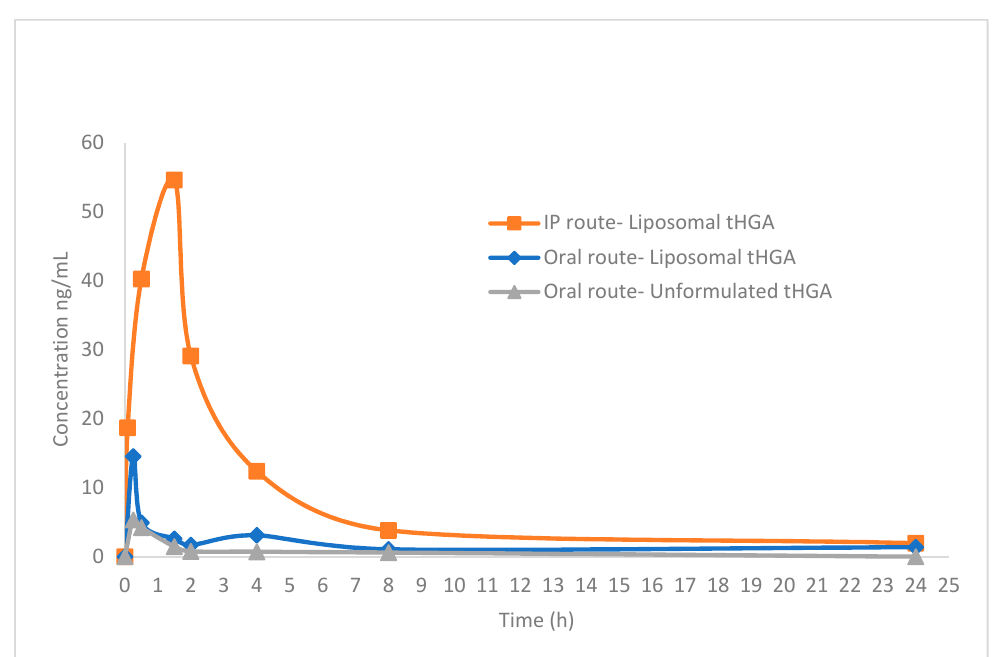
Figure 2. Plasma tHGA concentrations versus time profile for oral administration of liposomal formulation, oral administration of free tHGA, and intraperitoneal administration of tHGA, at a dose of 20 mg/kg. Data are represented as mean value (n = 6).